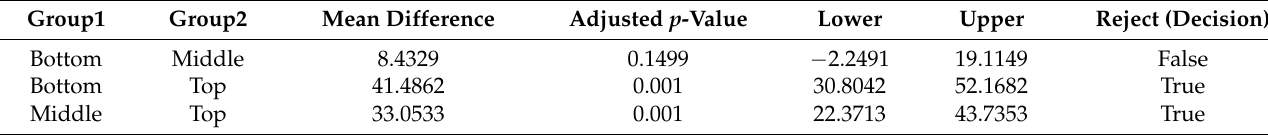
Figure 2. Mean SOC stock of each land use type across the depth classes. Multiple pairwise comparison of means using Tukey HSD test indicated that the SOC at the top layer was significantly different from that at the middle and bottom layers (see Table 7) at 0.05 level of significance. Table 7. Multiple comparison of means, level of significance =